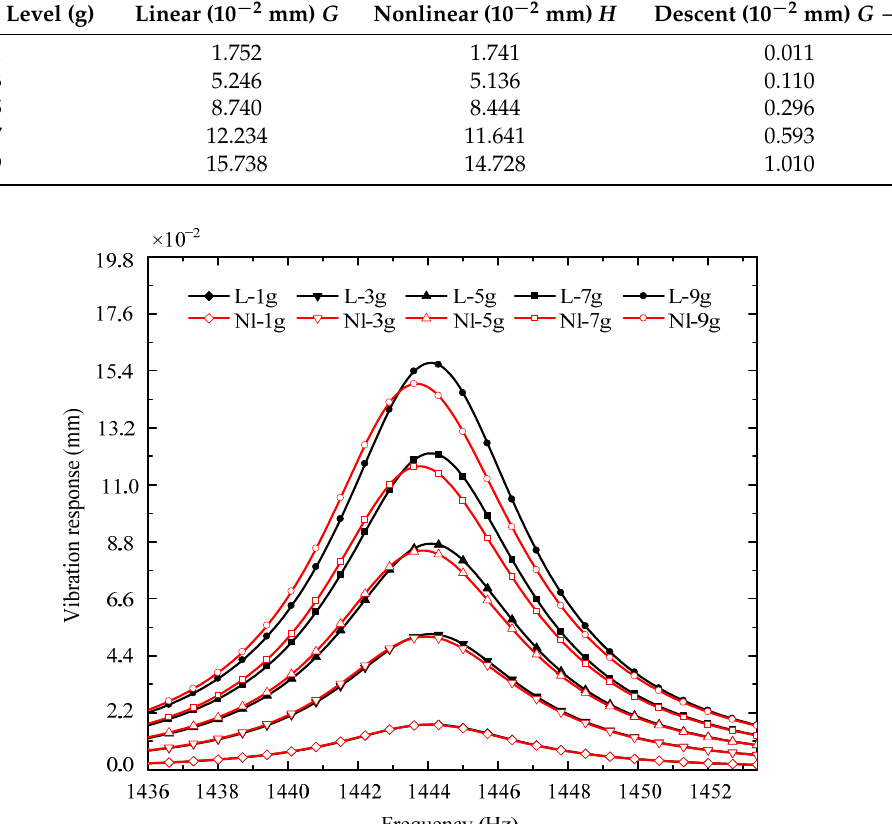
Figure 6. The three order linear and nonlinear frequency response spectrums of the hard-coating cylindrical shell under different excitation levels.